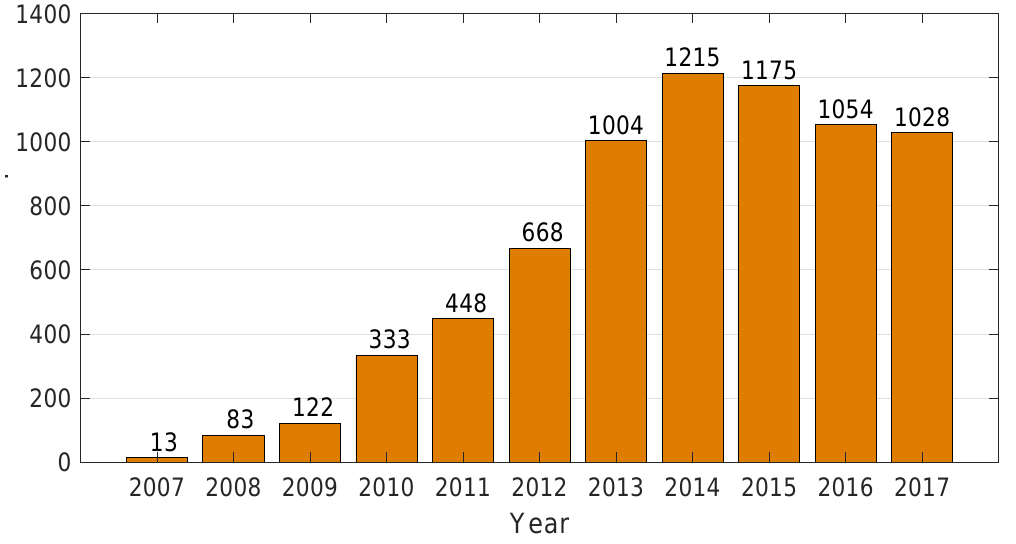
Figure 2. Number of poached rhinos in South Africa, adopted from the data published by the South African Department of Environmental Affairs (2017)